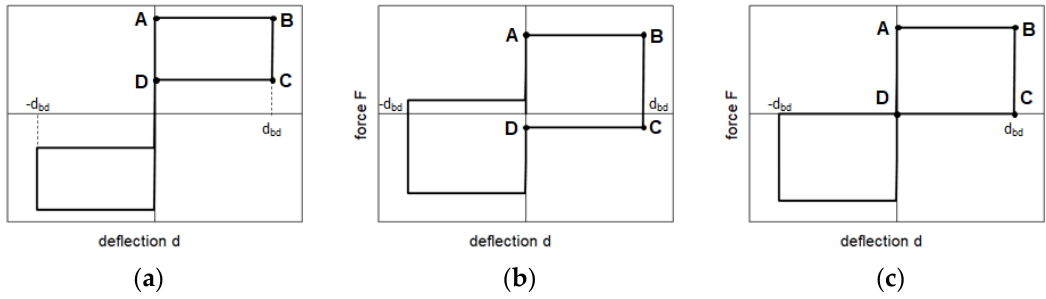
Figure 3. Backbone curves of the dissipative connection systems: ( a ) µ < tan( α ); ( b ) µ > tan( α ); ( c ) µ = tan( α